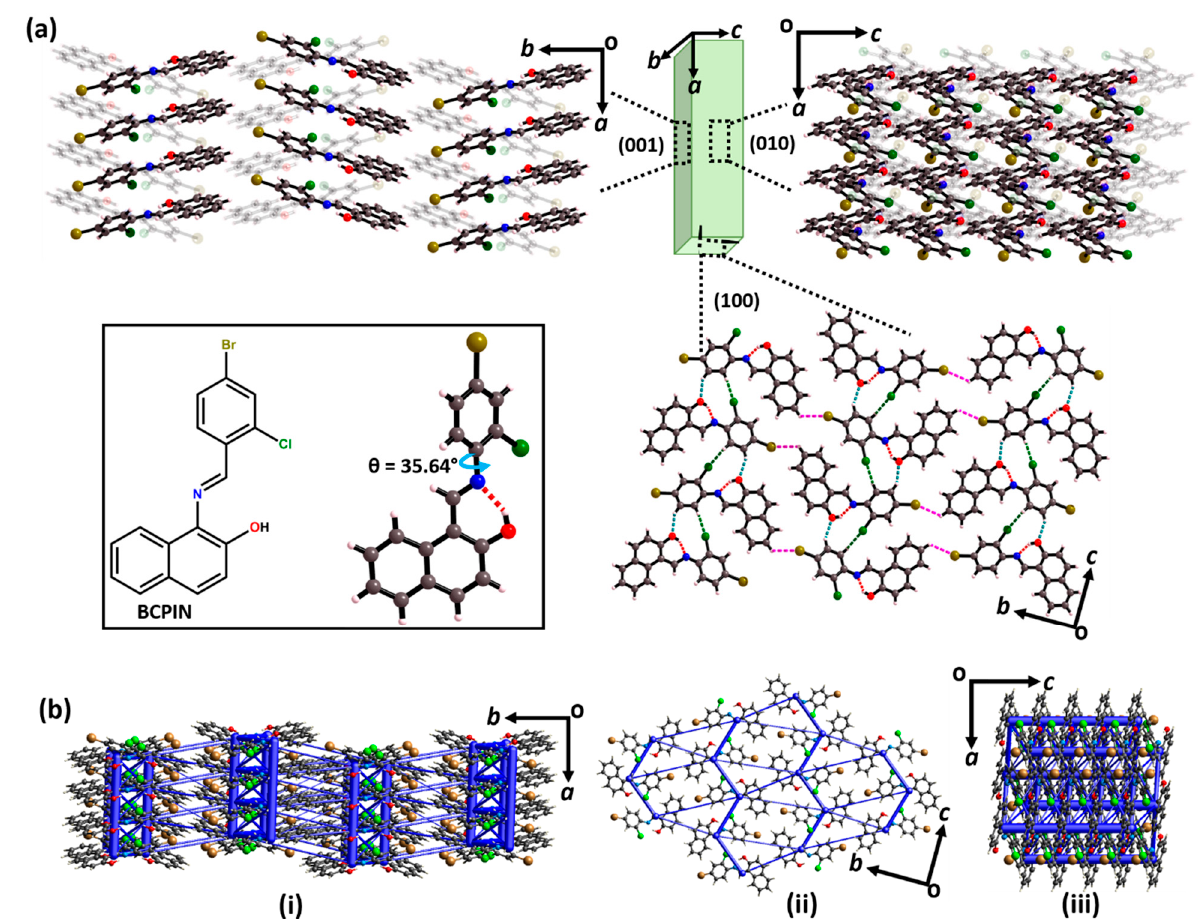
Figure 1. ( a ) Crystal packing in (E)-1-(4-bromo-2-chloro-phenyl)iminomethyl-2-hydroxyl-naphthalene (BCPIN). View of molecular arrangement on (001), (100), and (010) faces. The view of intermolecular interactions present in the crystal packing of BCPIN (O–H · · · N interactions: red dotted lines, C–H · · · O interactions: cyan dotted lines, C–H · · · Cl interactions: green dotted lines and C–H · · · Br interactions: magenta dotted lines). The molecular formula of BCPIN and molecular conformation are shown as an inset. ( b ) Energy frameworks showing the total intermolecular interactions energy (blue) viewed along the c -axis ( i ), a -axis ( ii ), and b -axis ( iii ). The line thickness represents the magnitude of energy (line size 100 and energy cut-off 5 kJ.mol − 1